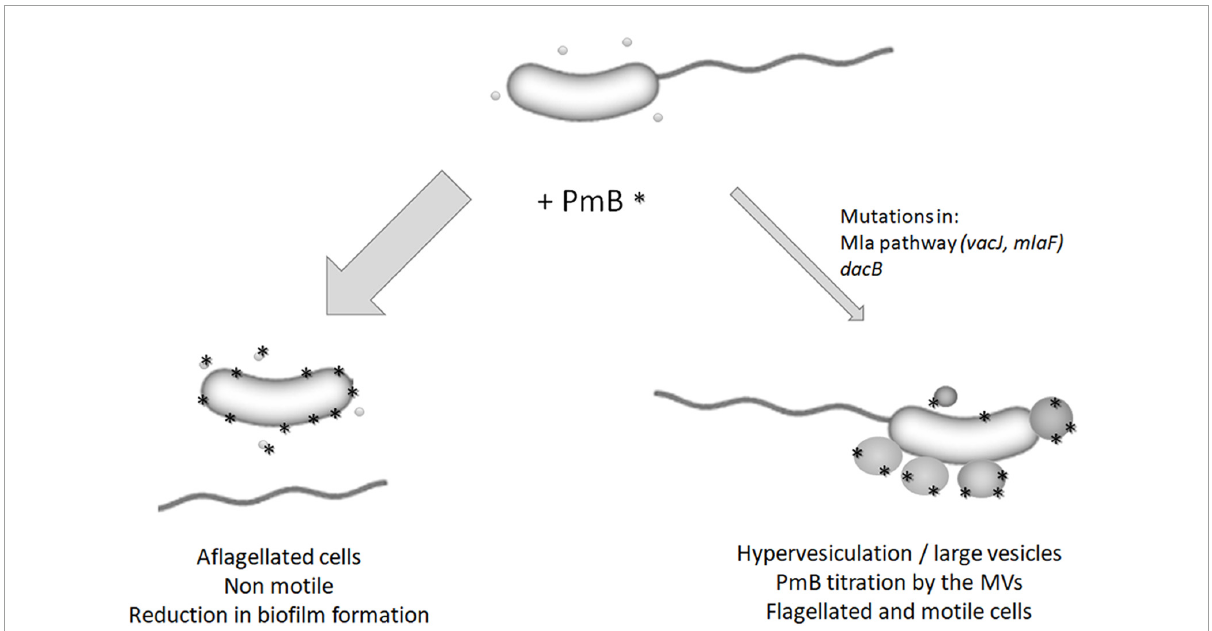
FIGURE9 Model for the impact of polymyxin B on V. cholerae MO10. In the presence of subinhibitory and non-pore-forming concentrations of PmB, most of the bacterial cells are aflagellated, which results in non-motile cells and a reduction in biofilm formation (Giacomucci et al., 2019). However, some cells can adapt to the presence of PmB by mutating genes involved in the regulation of the vesiculation process ( mlaF , vacJ, and dacB ). It results in hypervesiculation and the formation of large MVs that can titer the PmB, thereby reducing its impact on the bacterial membrane and flagellum’s assembly and anchoring. These cells are flagellated and